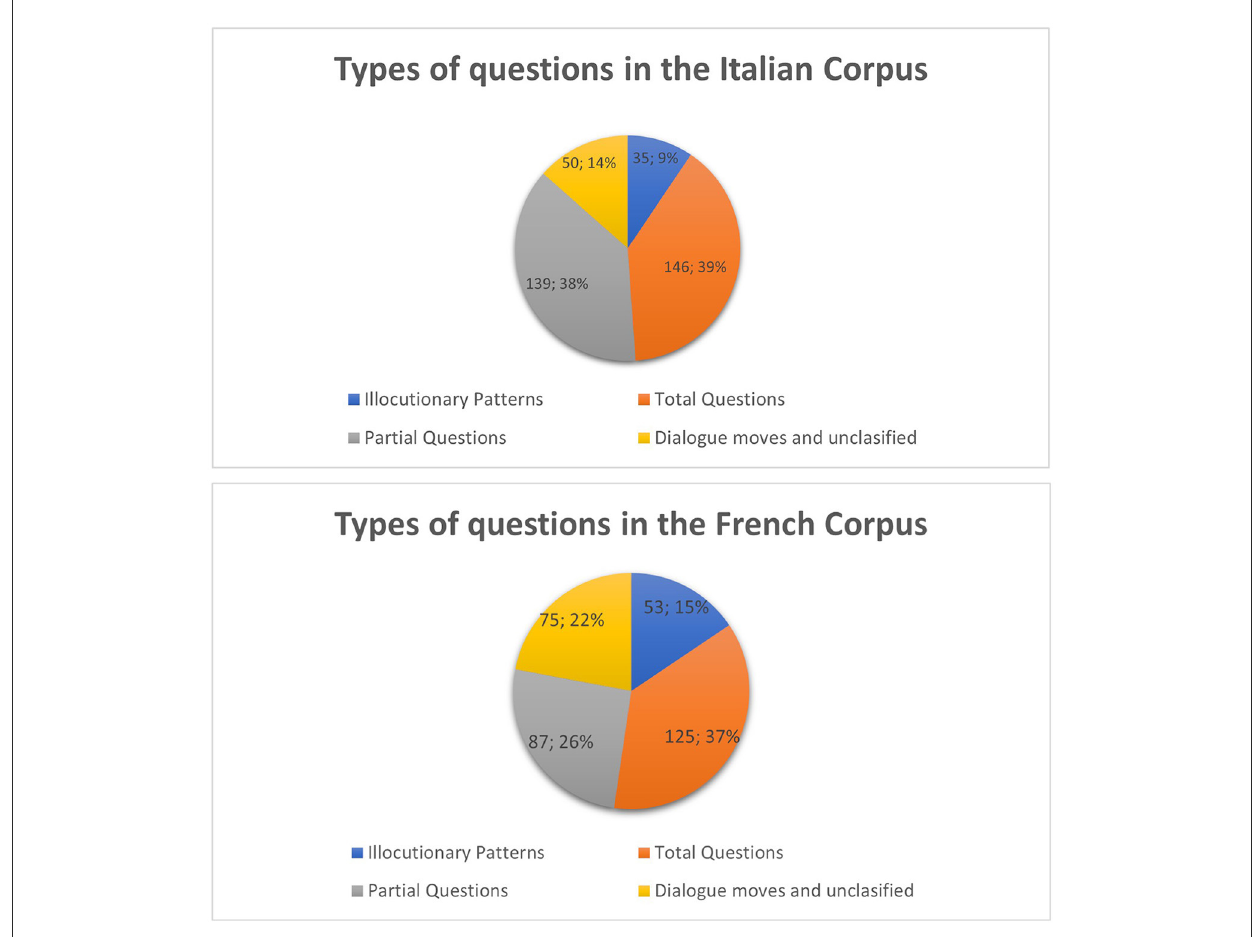
FIGURE2 Types of questions in the Italian and French